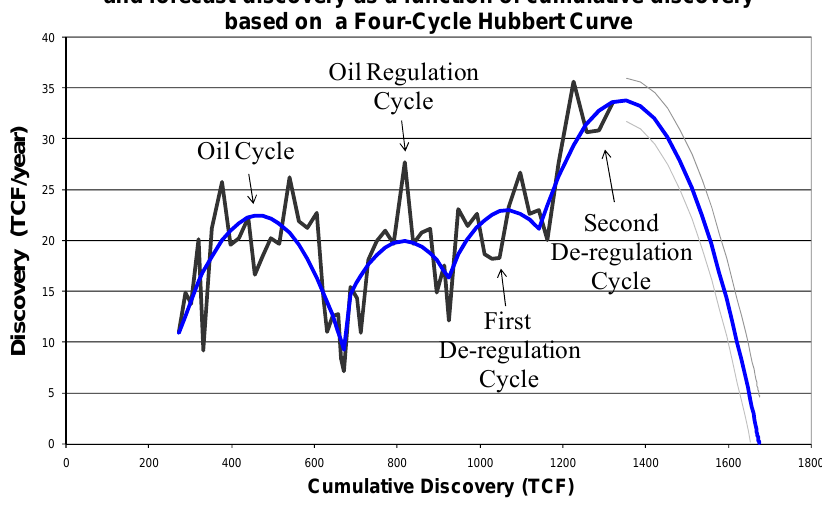
Table 7. Test of Unit